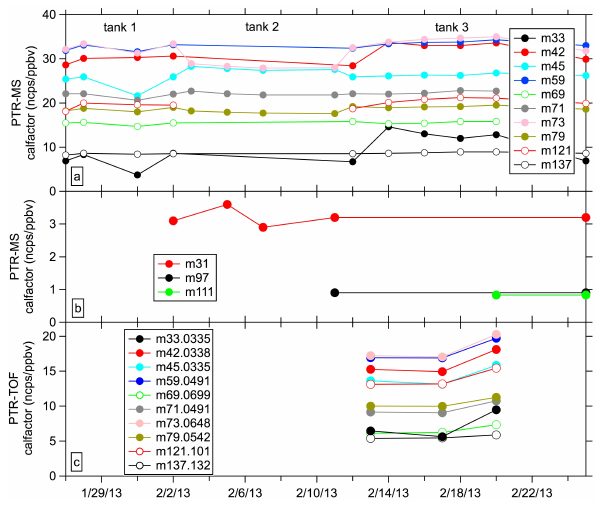
Figure 2. (a) Multiple VOC PTR-QMS calibration using three different calibration gas tanks during UBWOS2013: methanol (m33), acetonitrile (m42), acetaldehyde (m45), acetone (m59) iso- prene (m69), methacrolein (m71), methylethylketone (m73), ben- zene (m79), 1,3,5-trimethylbenzene (m121) and α -pinene (m137). (b) PTR-QMS calibrations using the MOCCS cart for formalde- hyde (m31), methylcyclohexane (m97) and dimethylcyclohexane (m111). (c) PTR-TOF calibration for the same compounds as in (a) during